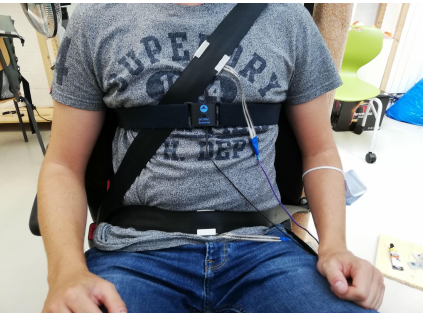
Figure 6. Setup for the second test session. The proposed system’s sensors were placed on the driver’s chest and abdomen, and the reference sensor attached at the chest.